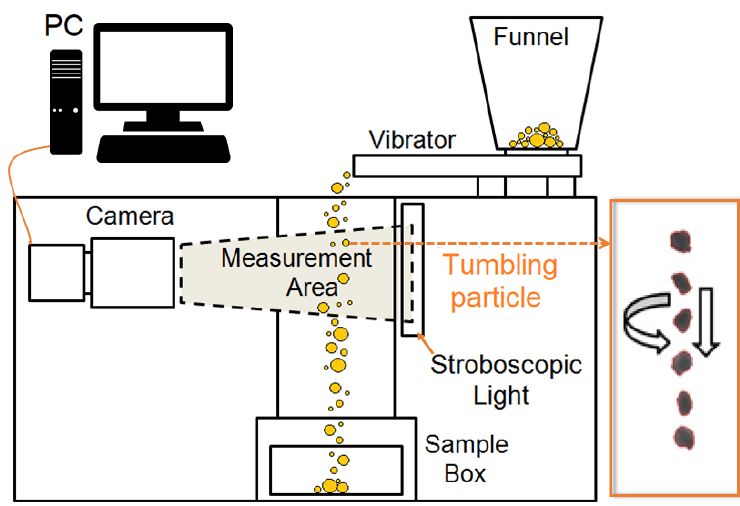
Figure 1. Principle of measurement by Dynamic image analysis (DIA) using PartAn 3D.